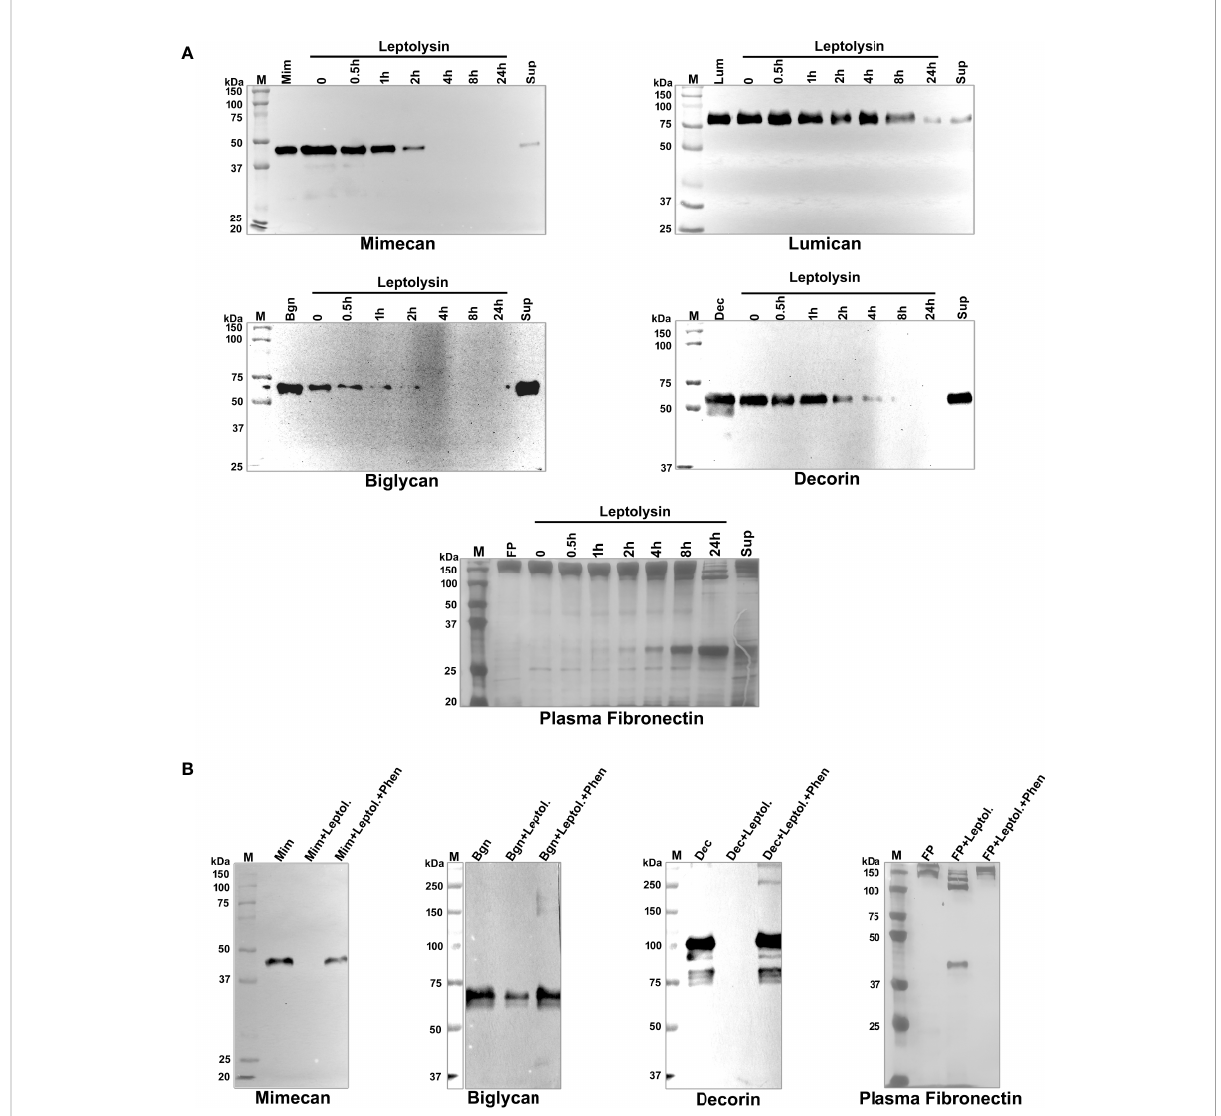
FIGURE 6 Proteolytic activity of L. interrogans leptolysin on proteoglycans and plasma fi bronectin. (A) Degradation of substrates: mimecan, lumican, biglycan, decorin (0.5 m g), and plasma fi bronectin (5 m g) were incubated with leptolysin (0.1 µg) at 37°C for the indicated time points. Cleavage products were subjected to SDS- polyacrylamide gel under reducing conditions, transferred to nitrocellulose membranes, and probed with speci fi c antibodies, or the gel was silver stained (FP). (B) Inhibition of proteolytic activity: before the addition of each substrate, leptolysin (0.1 µg) was incubated with 5 mmol/L 1,10-phenanthroline (lane 4) for 30 min at room temperature. Substrates were added and incubations proceeded for 24 h. Cleavage products were analyzed as described above. Mim (mimecan), Lum (lumican), Bgn (biglycan), Dec (decorin), FP (plasma fi bronectin), Sup ( Leptospira culture supernatant), Leptol. (leptolysin), Fen